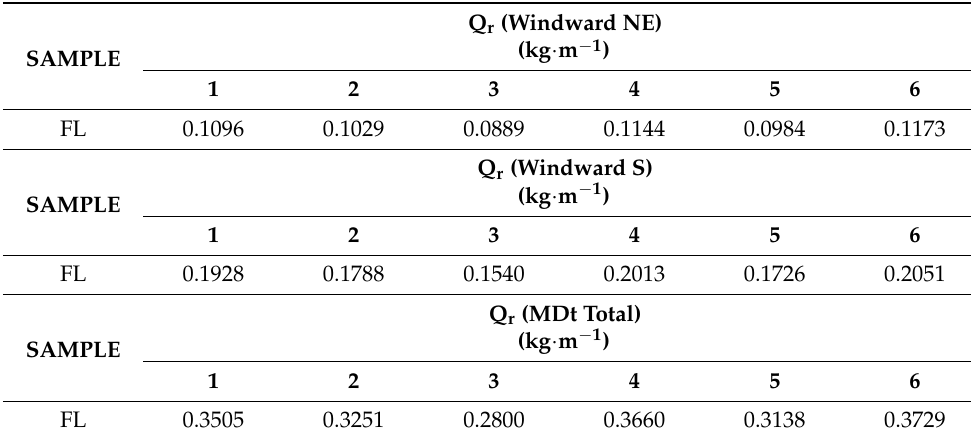
Table 3. Sediment transport rate